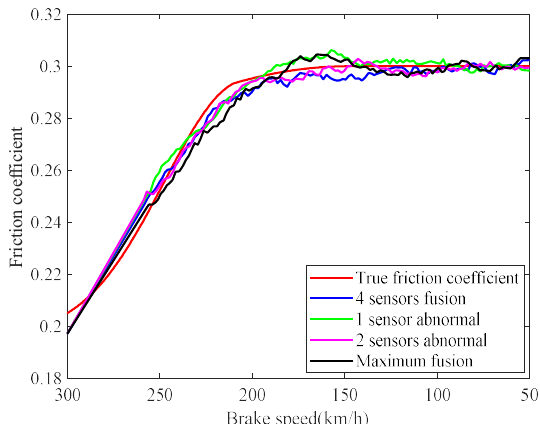
Figure 8. Identifications of friction coefficient.